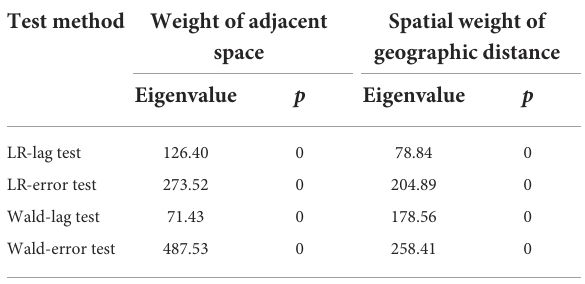
TABLE 3 LR and Wald